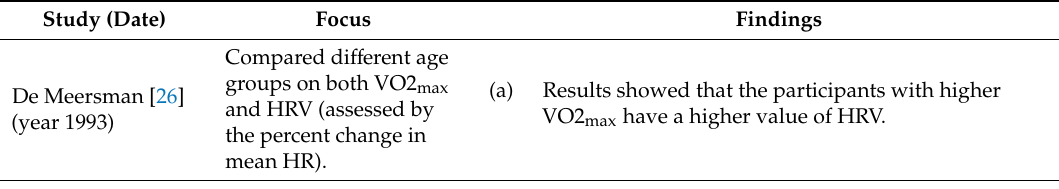
Table 2. A brief review of the literature showing the disparity in the reported